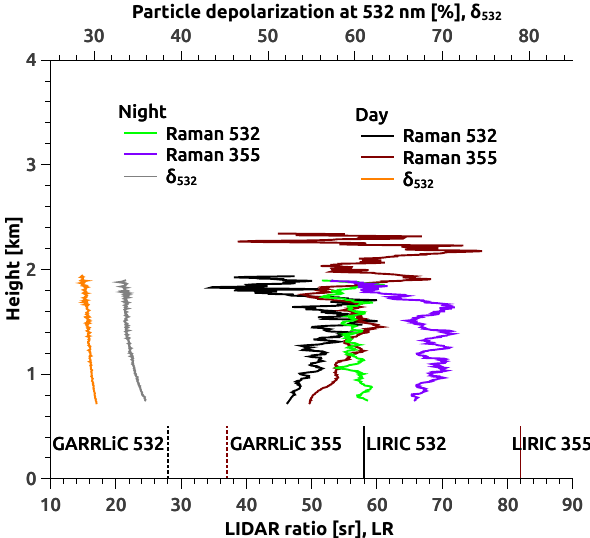
Figure 9. Raman, LIRIC, and GARRLiC extinction profiles during the day (AOD 440nm ≈ 1 . 35 ± 0 . 20 ; α ≈ − 0 . 04 ± 0 . 01) and night (AOD 440nm ≈ 0 . 83 ± 0 . 03 ; α ≈ 0 . 08 ± 0 . 02) on 29 March 2015.